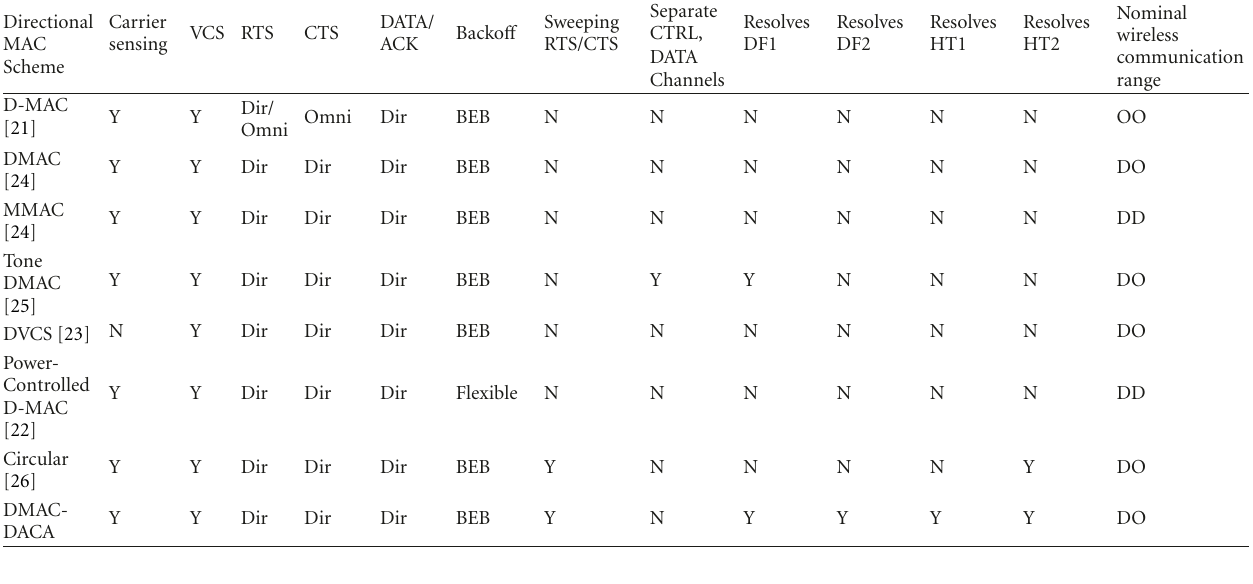
Table 2: Comparison between directional schemes, including the newly proposed DMAC-DACA.